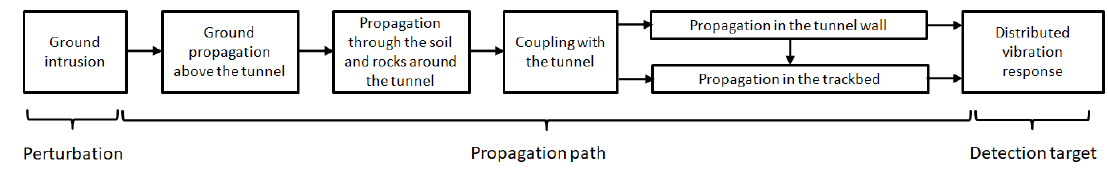
Figure 2. Propagation path of the intrusion load assumed by the detection principle .